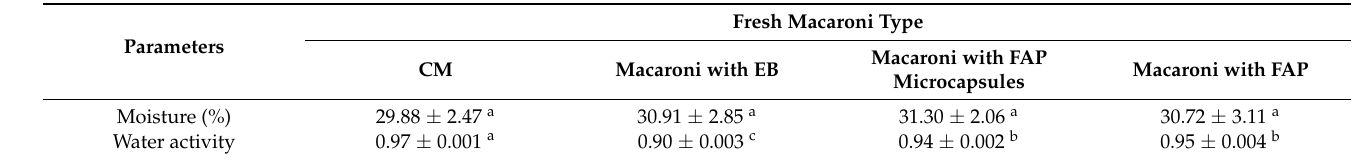
Table 2. Chemical quality indicators of the fresh macaroni formulations enriched with free or microencapsulated Azolla fern powder.